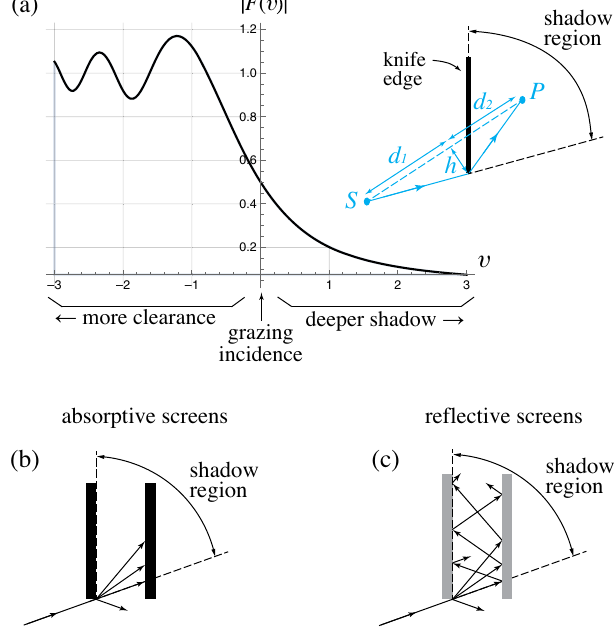
FIG. 2. (a) A canonical example of Fresnel diffraction of a plane wave caused by a single knife-edge obstruction (thin and absorptive screen). The field strength of the wave traveling from point S to point P diminishes according to the function j F ð ν Þj shown. As the point P moves deeper into the shadow region behind the screen, the attenuation is increased. The Fresnel defining the depth of shadow (or clearance) is found geometrically from the dimen- sions shown. (b) A simplified illustration of rays lost to diffraction, as they hit an absorptive screen or get diffracted into the shadow region bound by two such screens. (c) A simplified illustration of rays lost to reflection or diffraction in the region between two conductive